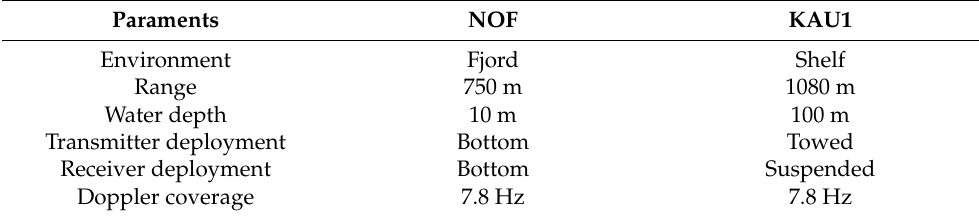
Table 4. Parameters of channel dataset.